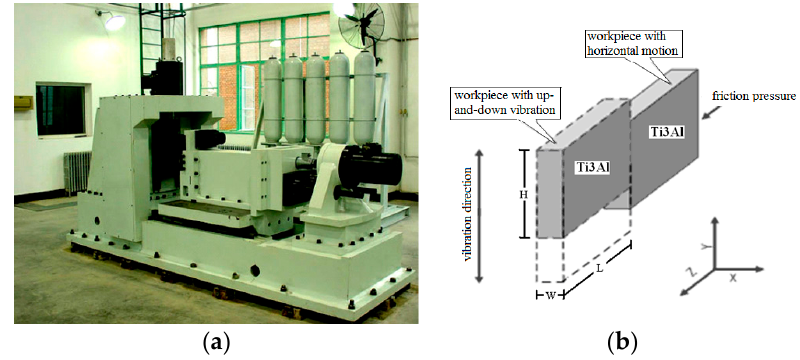
Figure 2. ( a ) The LFW-20T equipment; ( b ) Basic mechanism of the LFW process. The parameters of the Ti 3 Al LFW process are listed in Table 2.